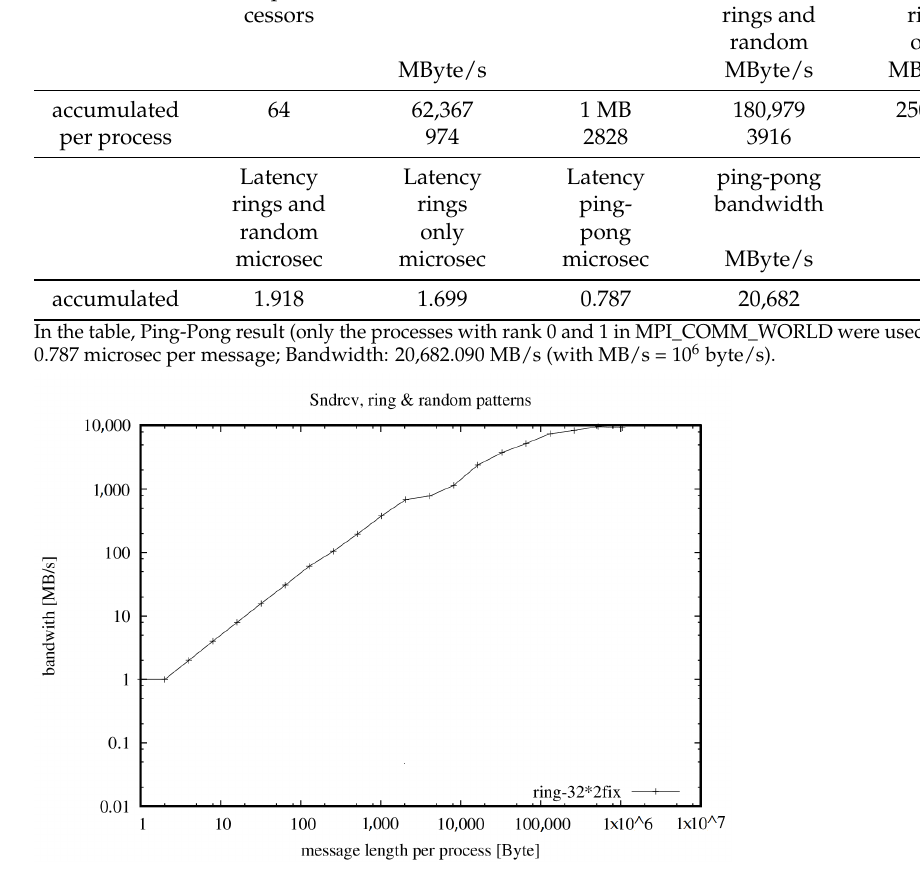
Figure 5. Bandwidth with 64 cores, two processes per node with span [ptile = 2] option added on queue